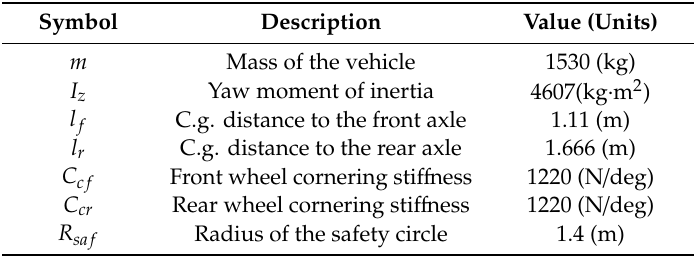
Table 4. The main parameters of the